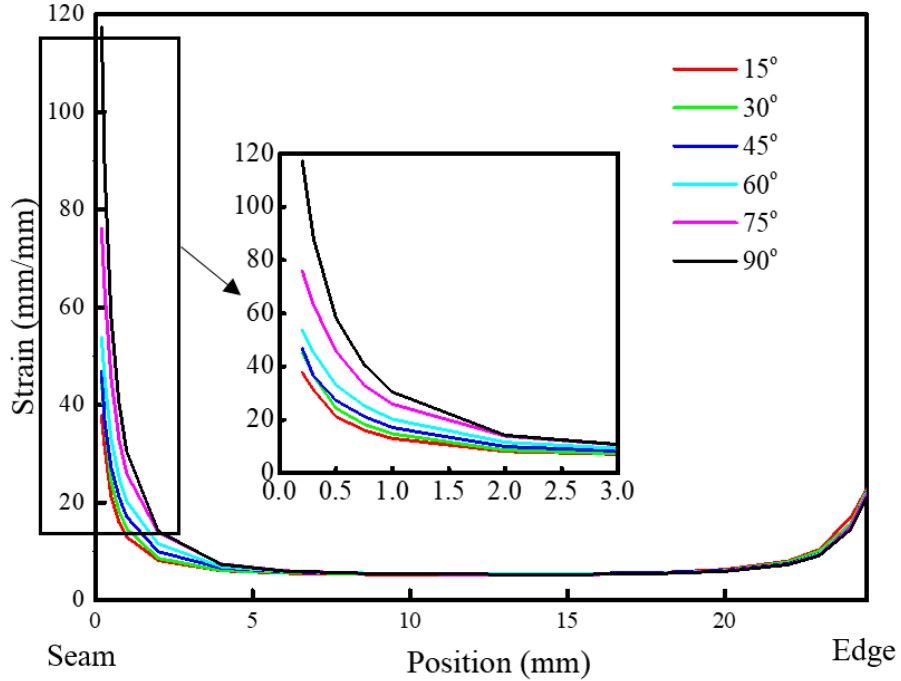
Figure 13. Model-predicted strain distribution showing the effect of lower bridge angle on the strain along the seam to the edge of the extrudate at the mid-thickness location (the red line in Figure 12f).